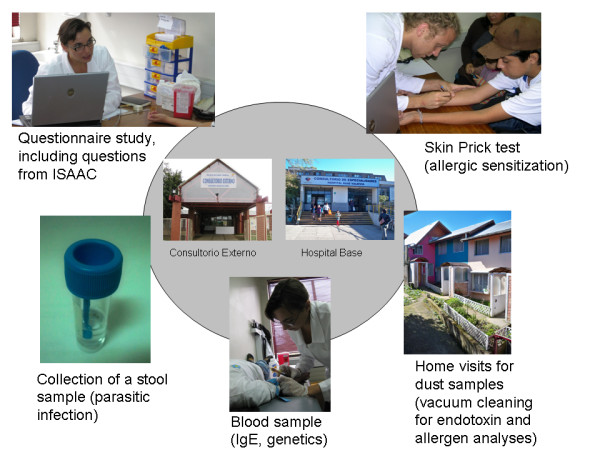
Description of the study parts done in Valdivia, Chile.